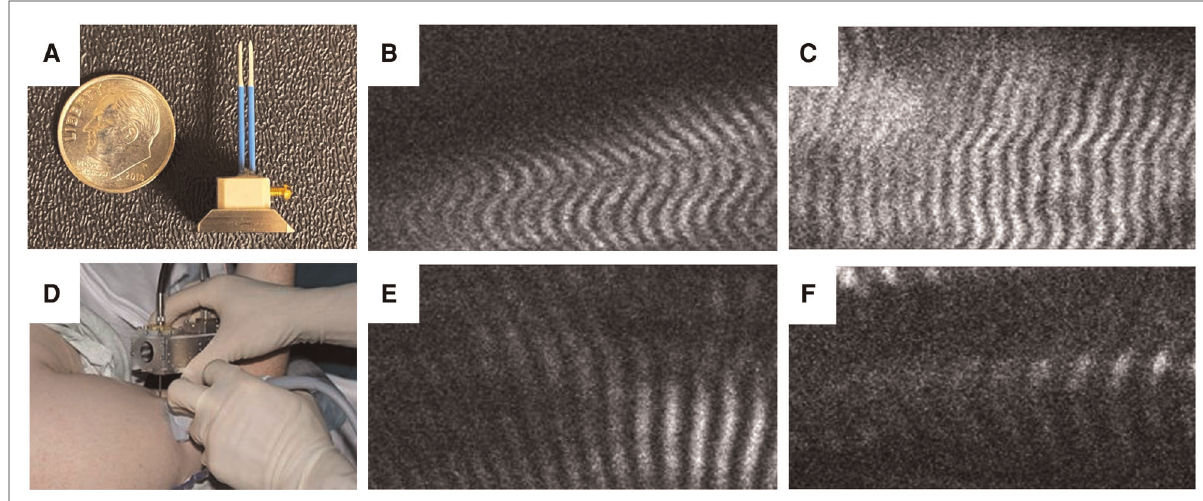
FIGURE 1 Needle microendoscopy of muscle sarcomeres. ( A ) Microendoscopic probe consisting of two 20-guage needles inserted into biceps muscle while mounted on handheld microscope ( B ) allows visualization of sarcomeres in real time as depicted from the unaffected and affected muscles in a subject with BPBI ( C,D , respectively) and a subject with CP ( E,F ,